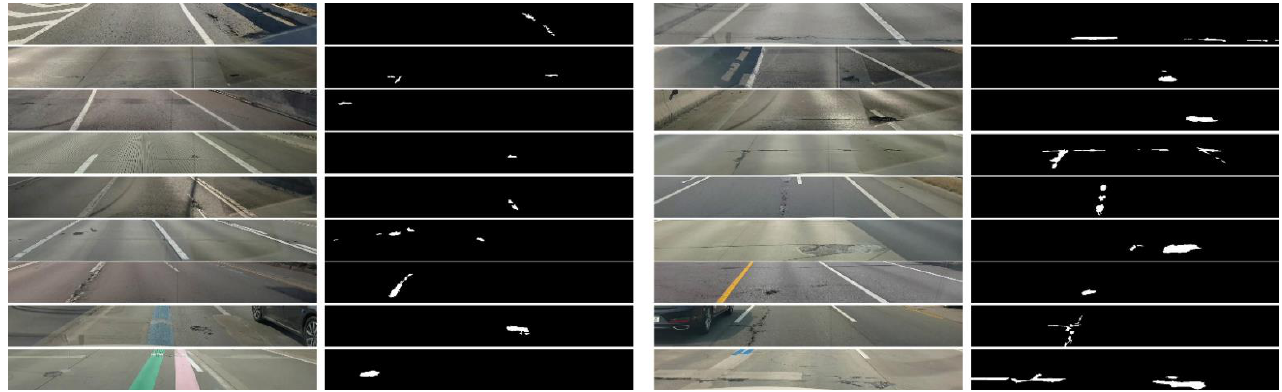
Figure 3. Datasets for training the road-surface crack segmentation model.